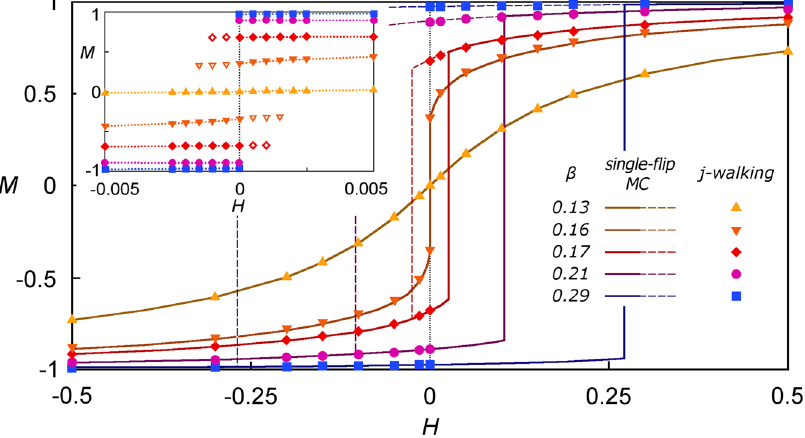
Figure 2. Magnetisation reversal, i.e. the mean magnetic moment M vs external field H , for the Ising model defined on bcc lattice with the same parameters as in Fig. 1, for several temperatures as marked in the legend. The data represented by solid (dashed) lines refer to increasing (decreasing) magnetic field and were obtained by the single-flip conventional (kinetic) MC simulations. For equilibrium isotherm at β = 0.13 (  ), the solid and dashed lines coincide. For β = 0.16 (  ), a small hysteresis loop exists but is not distinguishable on the scale of the graph. The symbols represent results of the JW MC simulations. The inset shows magnified region around H = 0. The solid (open) symbols in the inset refer to the mean magnetisation at energetically favourable (unfavourable) minimum of the free energy. The dotted horizontal lines in the inset serve as a guide for eye representing the value of magnetisation at the deepest minimum in the free-energy landscape. The dotted vertical line marks the transition at H =